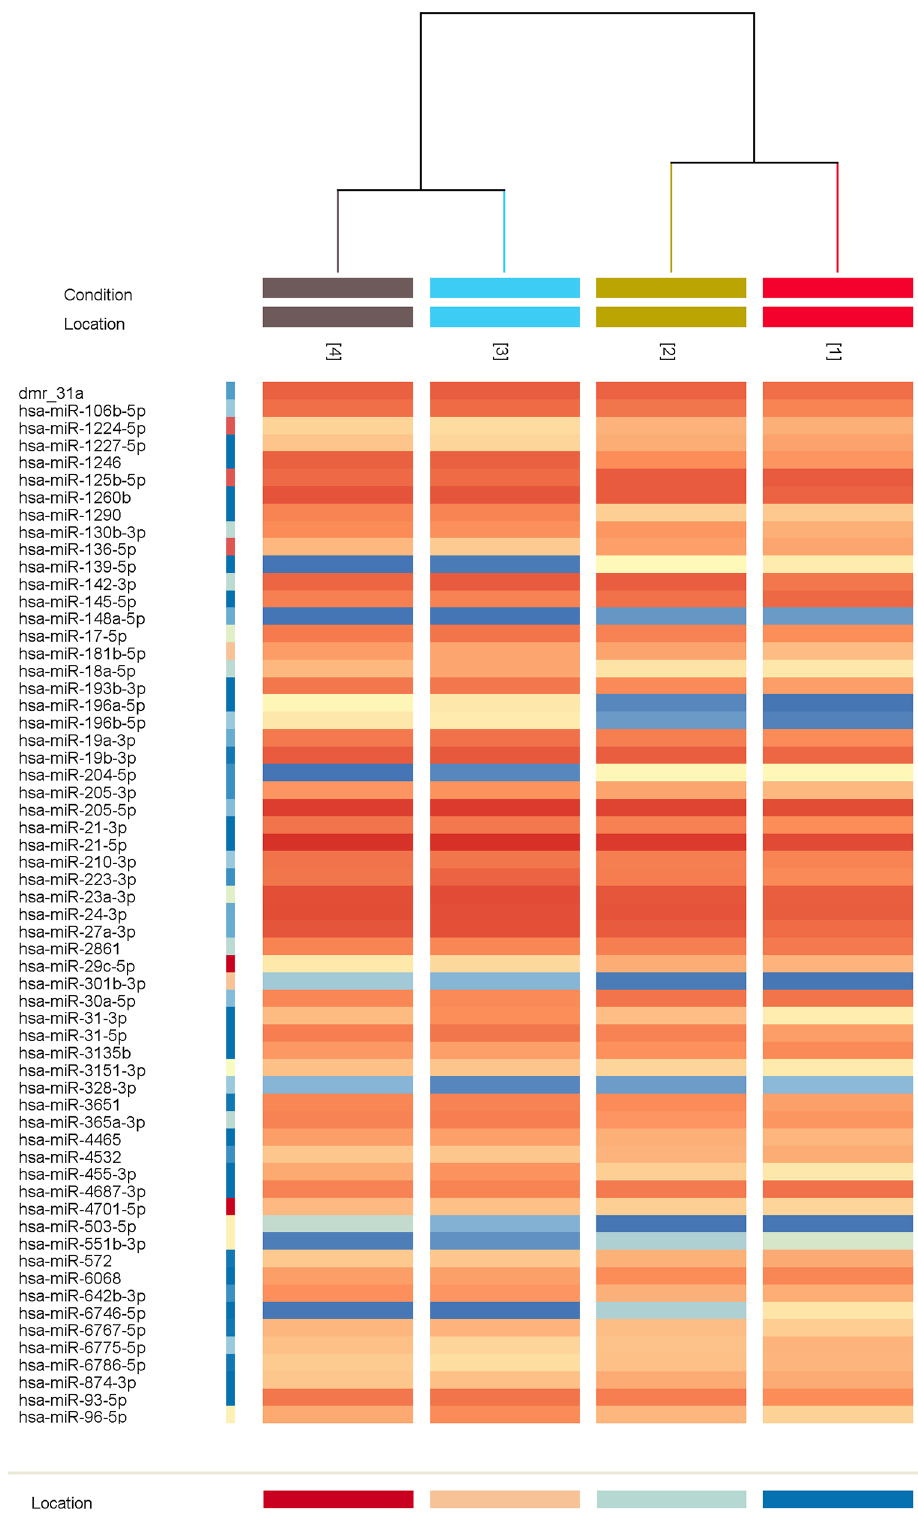
Figure 1. Cluster analysis of significantly dysregulated miRNAs from the global microarray profile of 2549 microRNAs in 12 patients with advanced laryngeal carcinoma 7 . Legend: (1) tumor surface; (2) tumor depth; (3) peritumor mucosa; (4) normal laryngeal